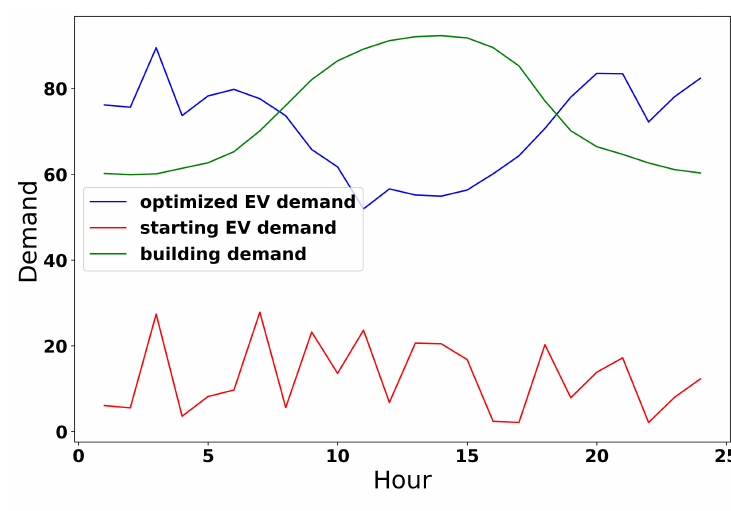
Figure 8. Target EV demand